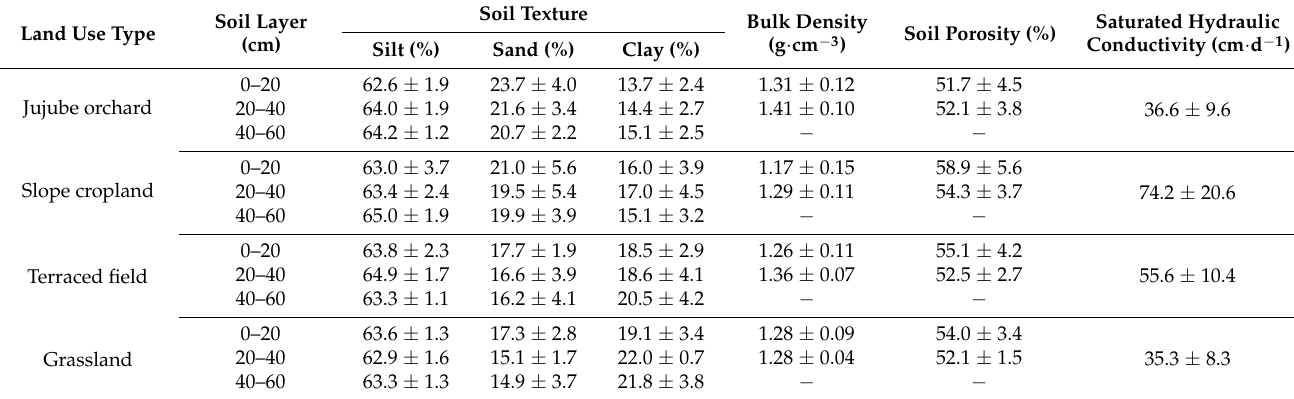
Table 1. The basic physical properties of the soil in the experimental